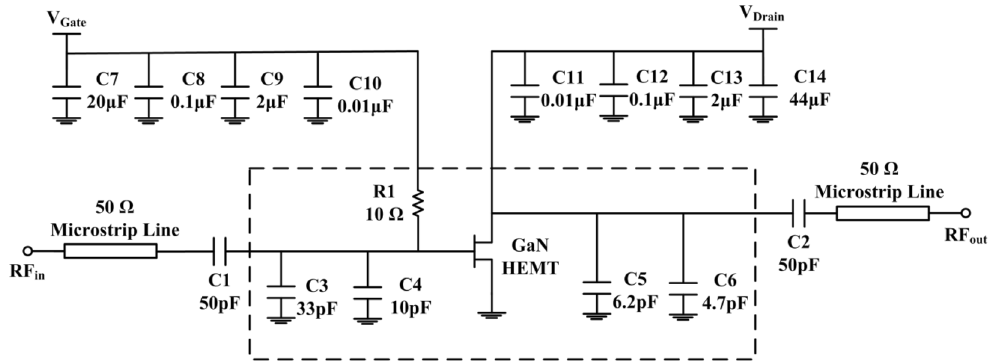
Figure 1. Structure of the power amplifier used in the study.